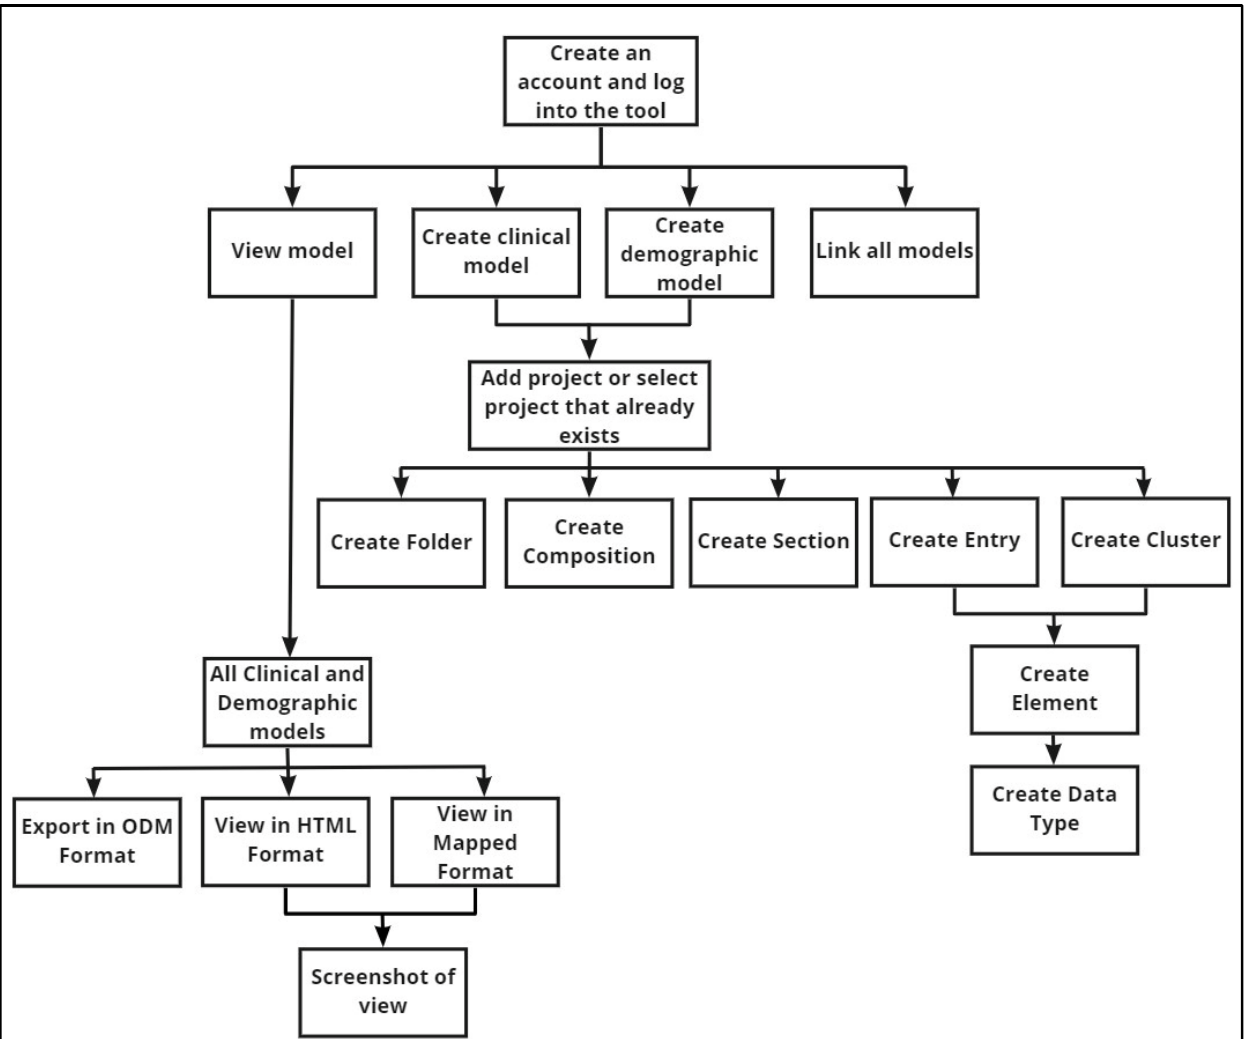
Figure 1. Schematic diagram showing the flow chart of the use of Direcht to model data dictionary items. HTML—hypertext markup language; ODM—operational data model.